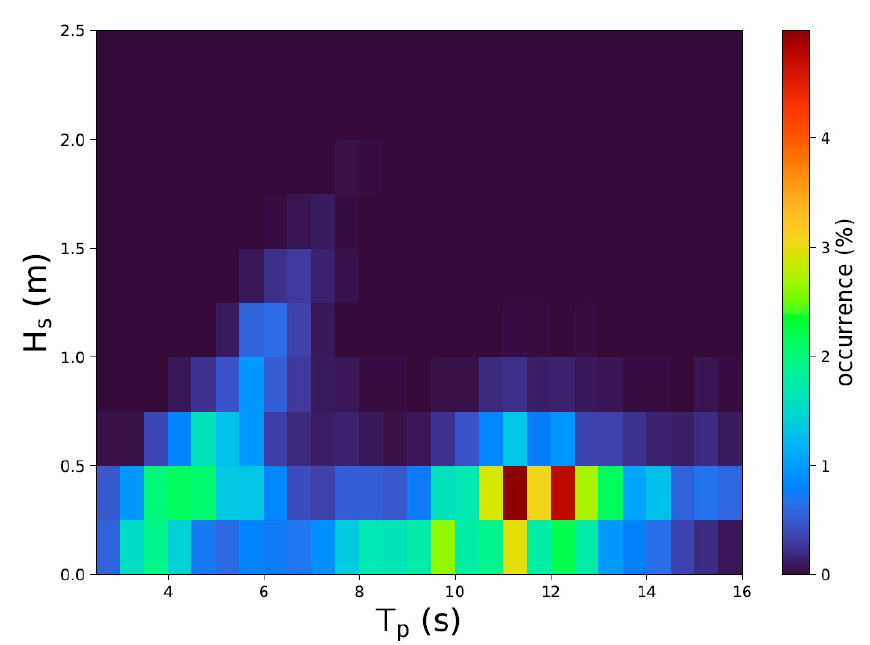
Figure 3. Mean distribution of wave events for a range of significant wave heights H s and peak periods T p at wave buoy 02910 during the year 2011. The color bar shows the occurrence of wave events in percentages.